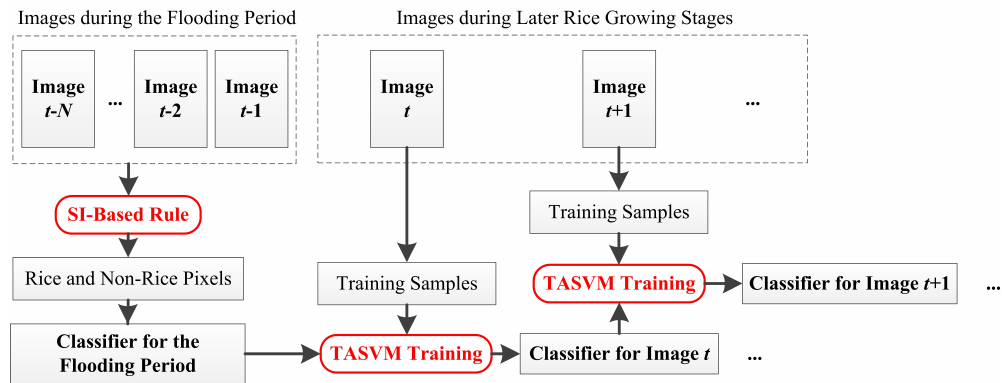
Figure 1. The proposed sequential classifier training procedure for rice mapping. SI: Spectral Index; TASVM: Temporal-Adaptive Support Vector Machine.